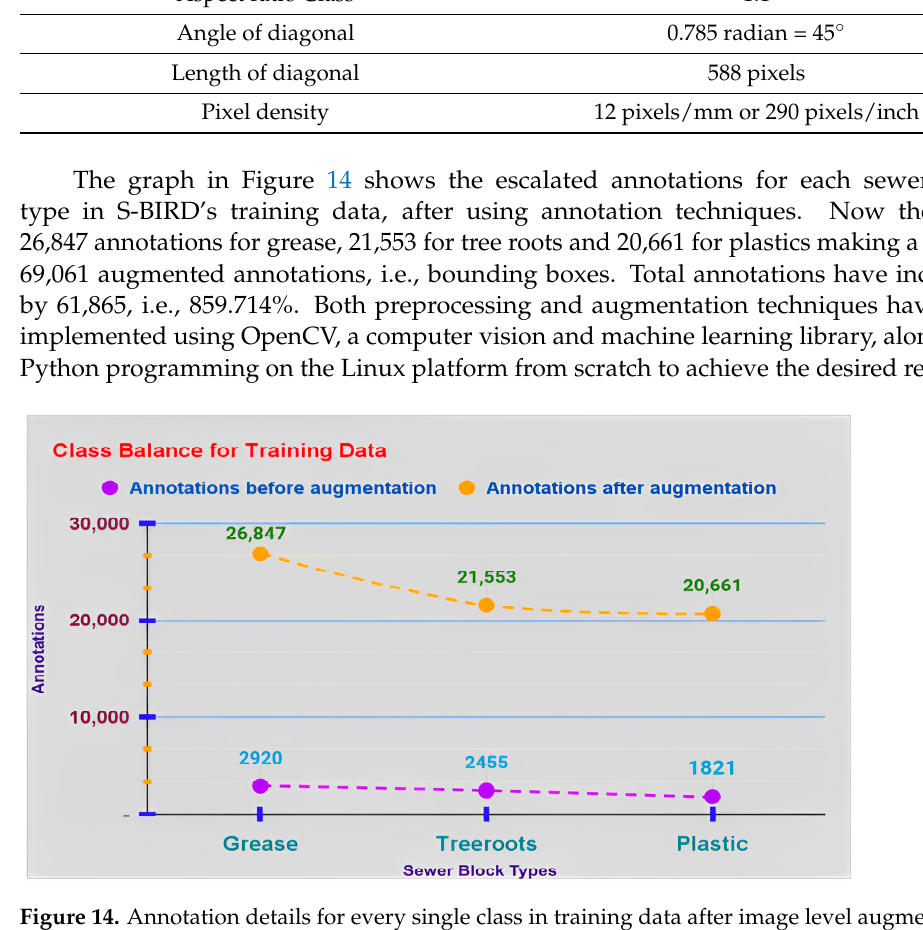
Figure 14. Annotation details for every single class in training data after image level augmentation.